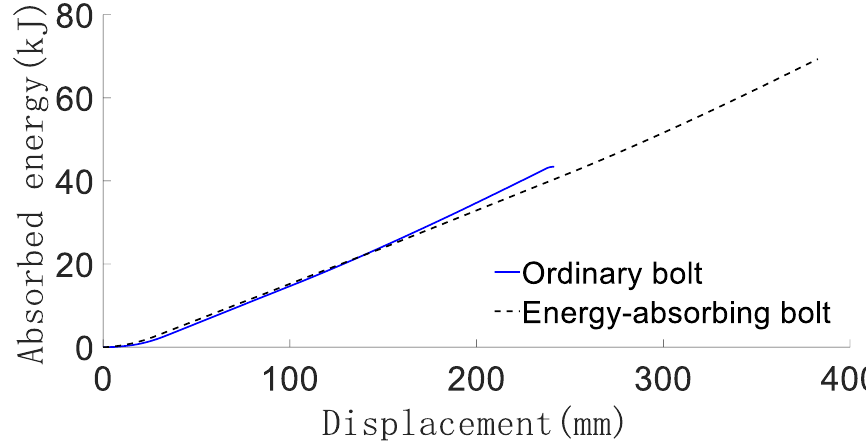
Figure 6. Anchor energy–absorption–displacement curve .